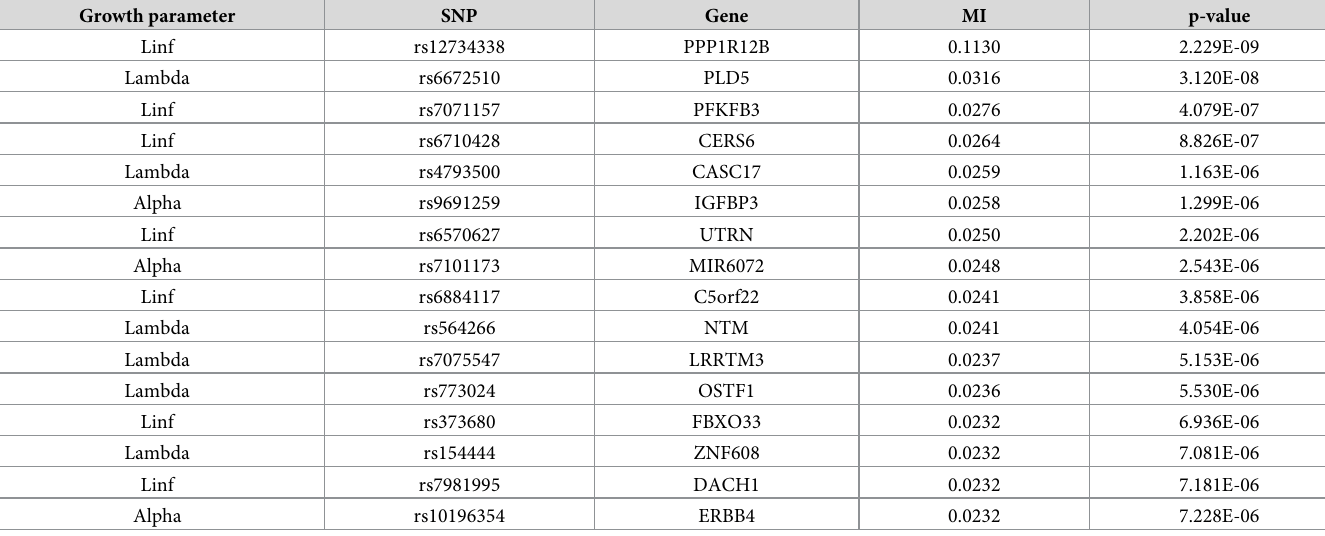
Table 3. Significant SNPs associated with each of growth phenotypes ( linf , lambda and alpha ) using two-way dependency measures (mutual information, MI). Growth